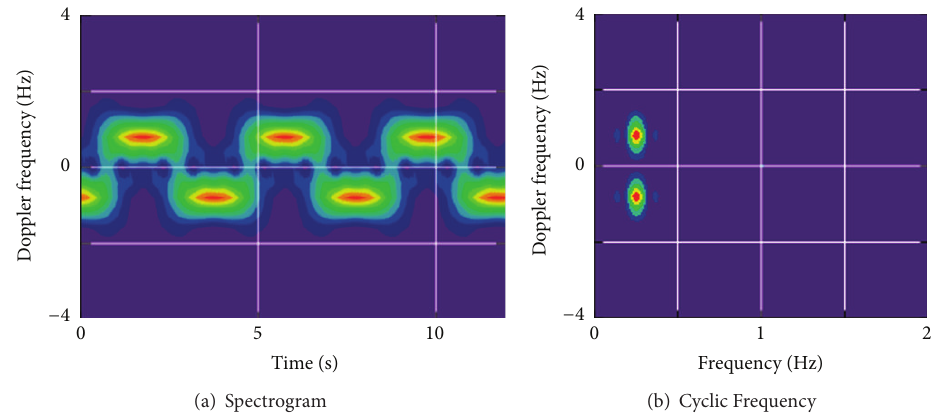
Figure 3: The proposed data processing method with a displacement period of 1s.